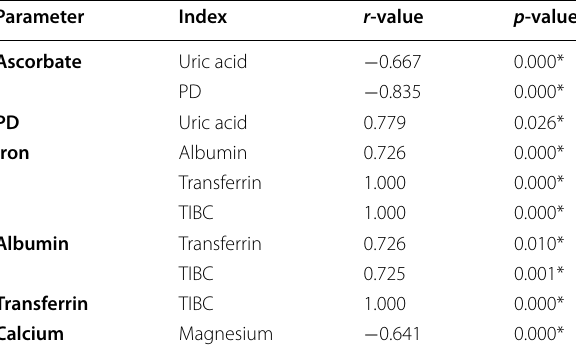
*Significant at P < 0.05, PD , parasite density, r -value — correlation coefficient